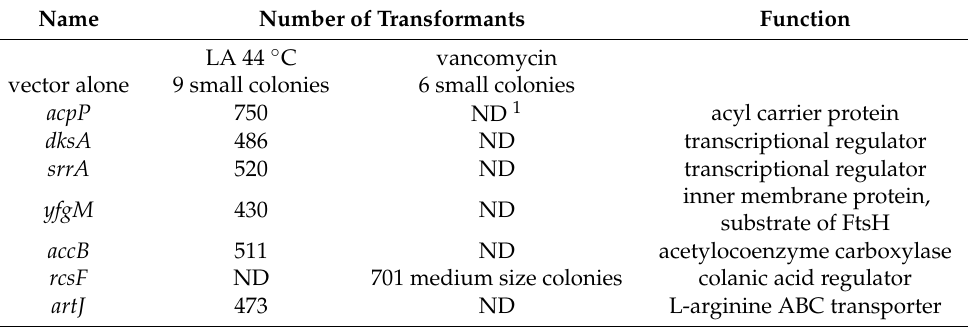
Figure 13. Overexpression of specific genes, including the acpP gene, restores the growth of ∆ lapD bacteria at 44 ◦ C. Growth of isogenic cultures of ∆ lapD bacteria transformed with either plasmid DNA of the vector alone or when the specific multicopy suppressing gene is present on the plasmid was quantified by spot dilution on LA at 37 and 44 ◦ C. The relevant genotype and temperature of incubation are indicated. Table 3. Identification of the most relevant multicopy suppressors of ∆ lapD